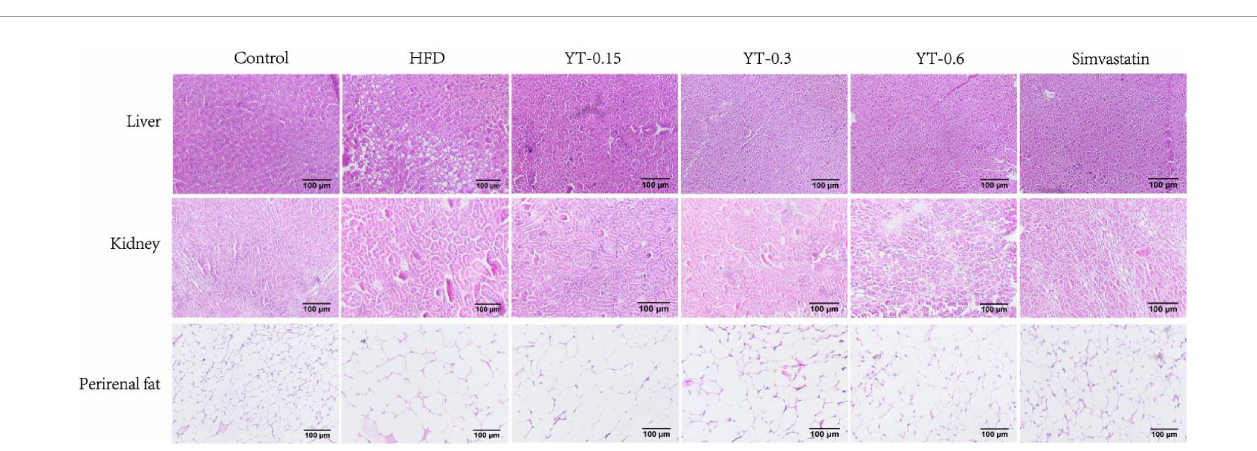
(37). OPLS-DA can be used to clearly depict changes in the metabolic profile. The OPLS-DA score plot ( Figure 5A ) shows a significant separation between the control and HFD groups, and ( Figure 5B ) shows significant separation between the HFD and YT-0.6